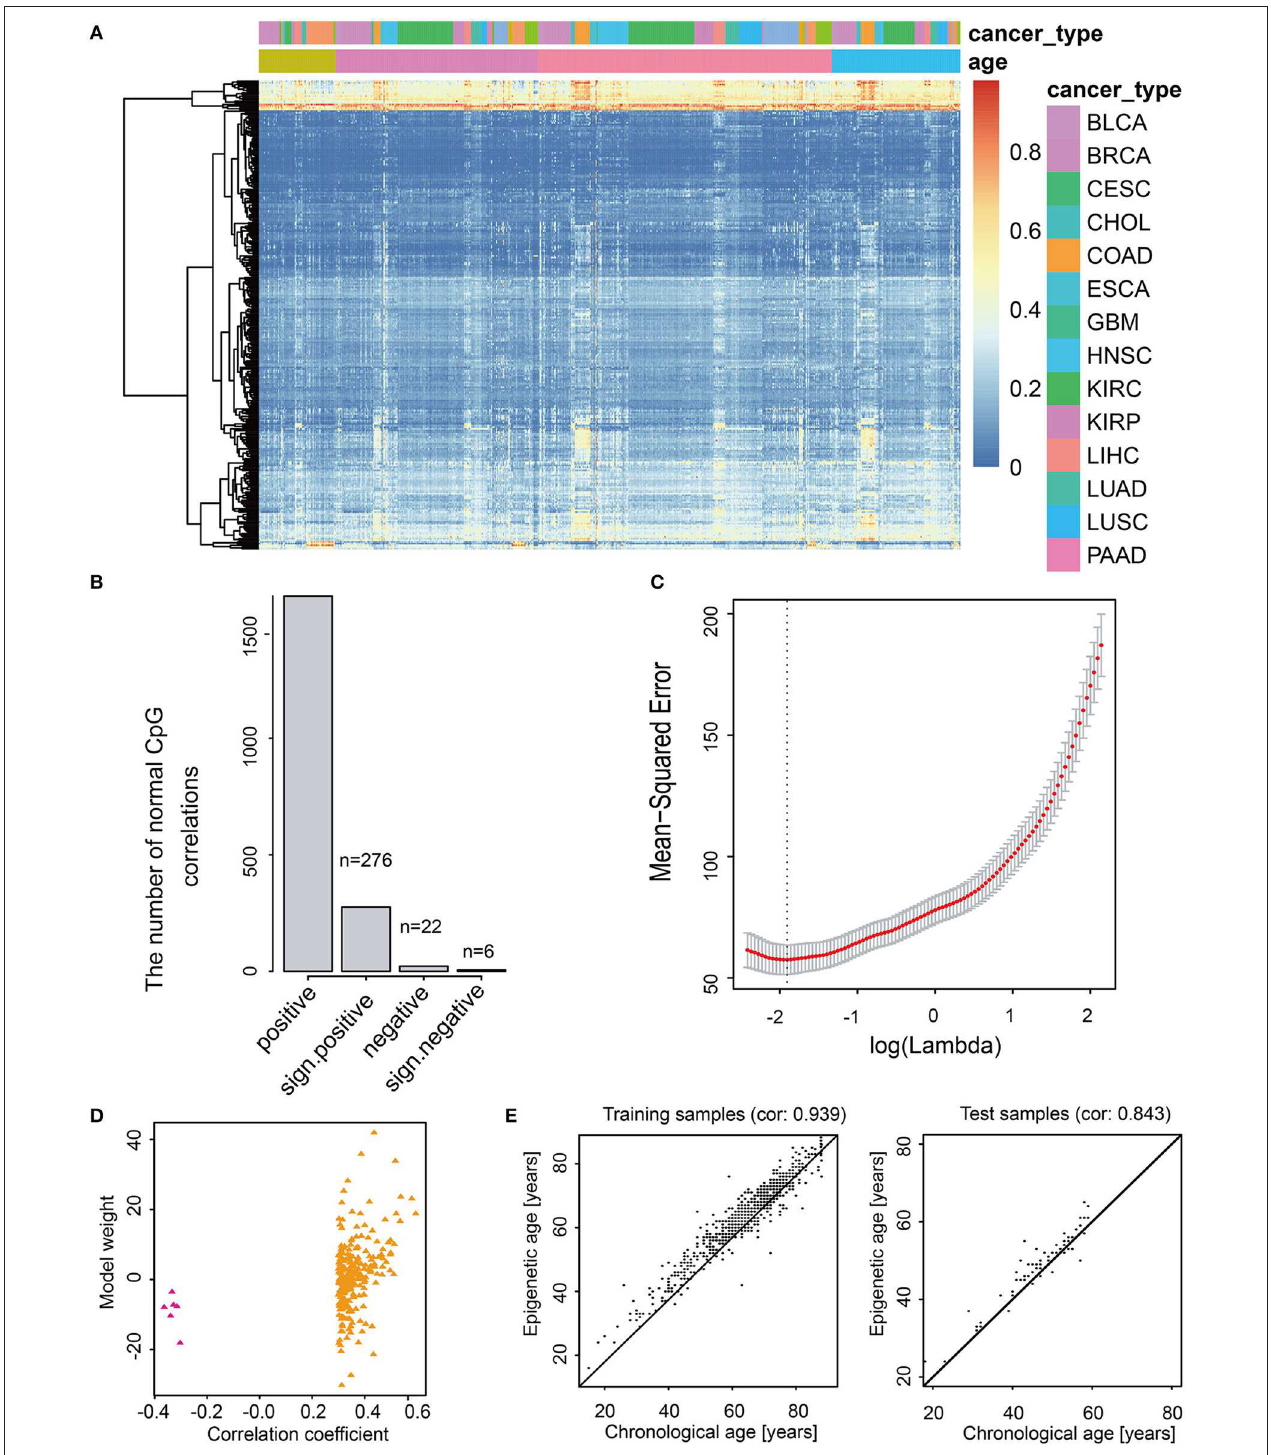
FIGURE 2 | Feature selection and model construction of CancerClock. (A) The heatmap shows the 282 age-related methylation sites extracted by the model in all cancer samples. The red and blue represent high and low levels of methylation sites. (B) The barplot shows the number of 282 positive and negative age-related methylation sites. (C) The selection of thresholds in LASSO regression model. The line represents the coefficient values, and the minimum mean-square error corresponding to log(Lambda) is − 1.95197. (D) Scatter diagram shows the correlations between correlation coefficient and model weight of CancerClock. (E) The correlation between chronological age and predicted m-age in the training set and the correlation between chronological age and predicted m-age in the test set.